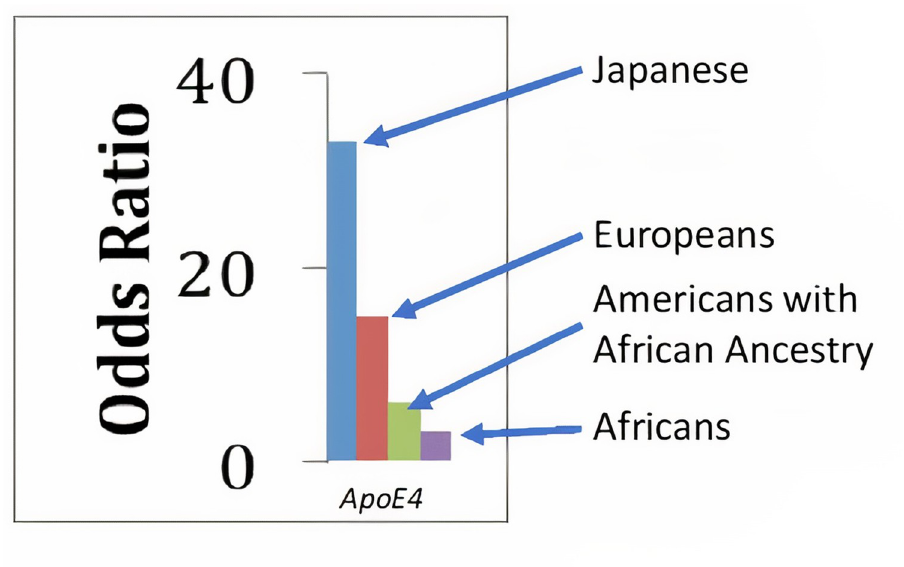
Fig 1. Odds ratios for developing Alzheimer disease according to ApoE ε 4/ ε 4 genotypes carriers relative to the ε 3/ ε 3 carriers across the multiple